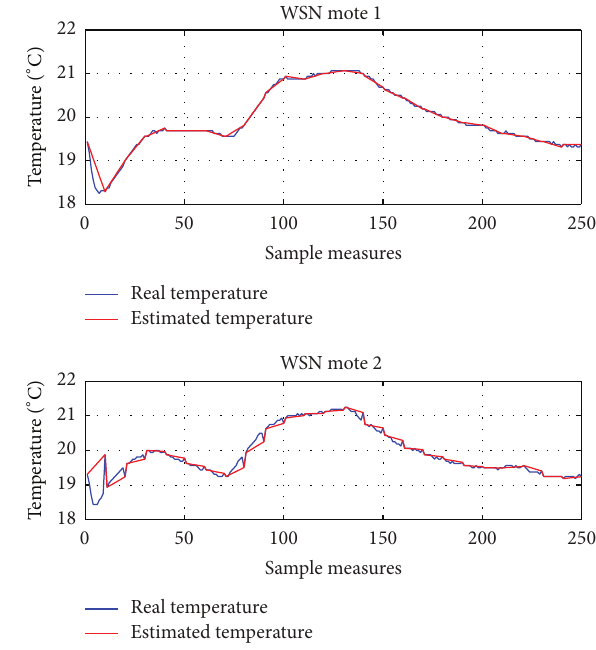
Figure 11: Real and estimated temperature using DES-CCR ( 𝜃 = 0.2 ). Figure 12: Real and estimated temperature using DES-CCR ( 𝜃 =